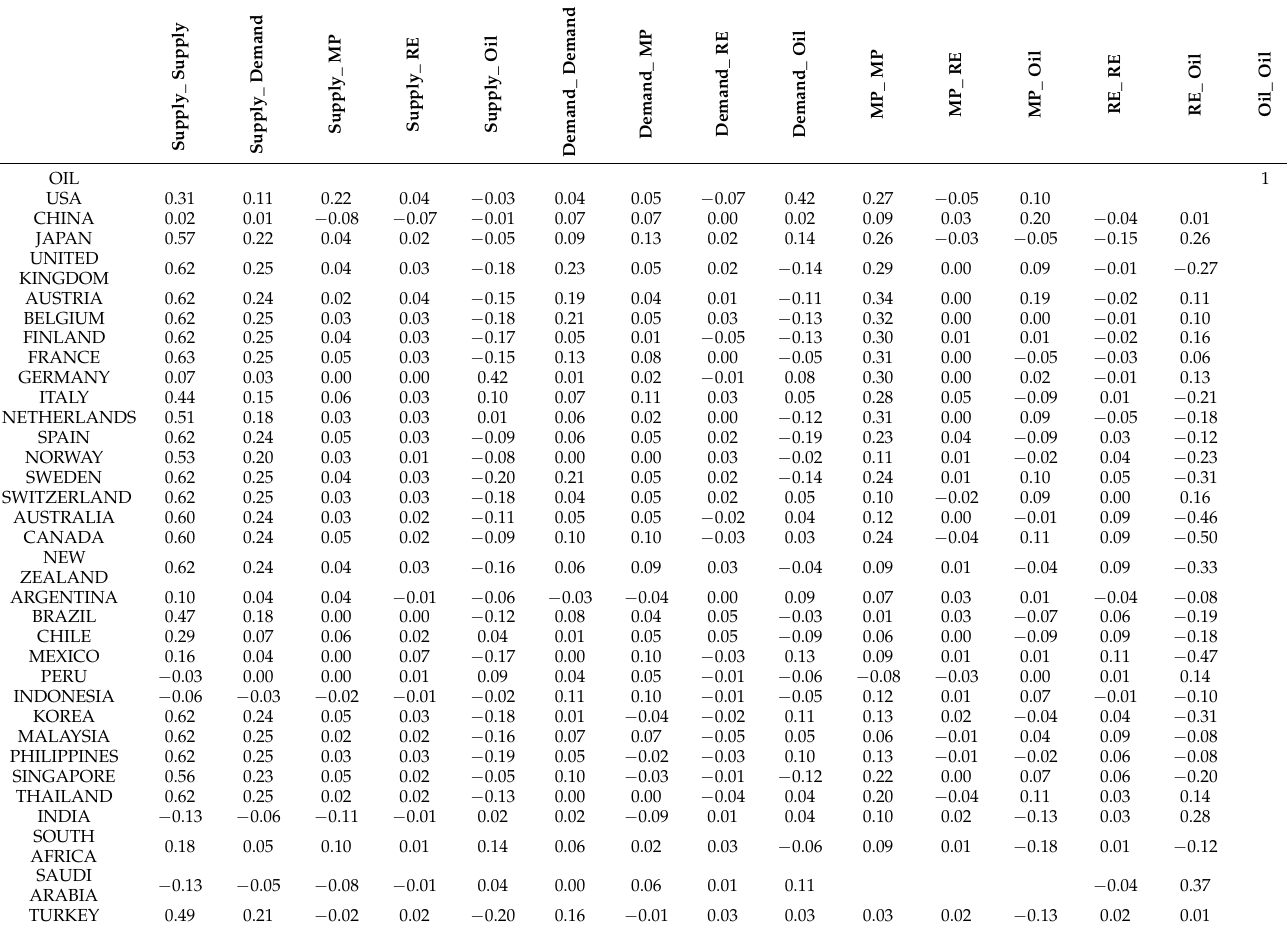
Table A4. Average Pairwise Correlations—DSGE-GVAR